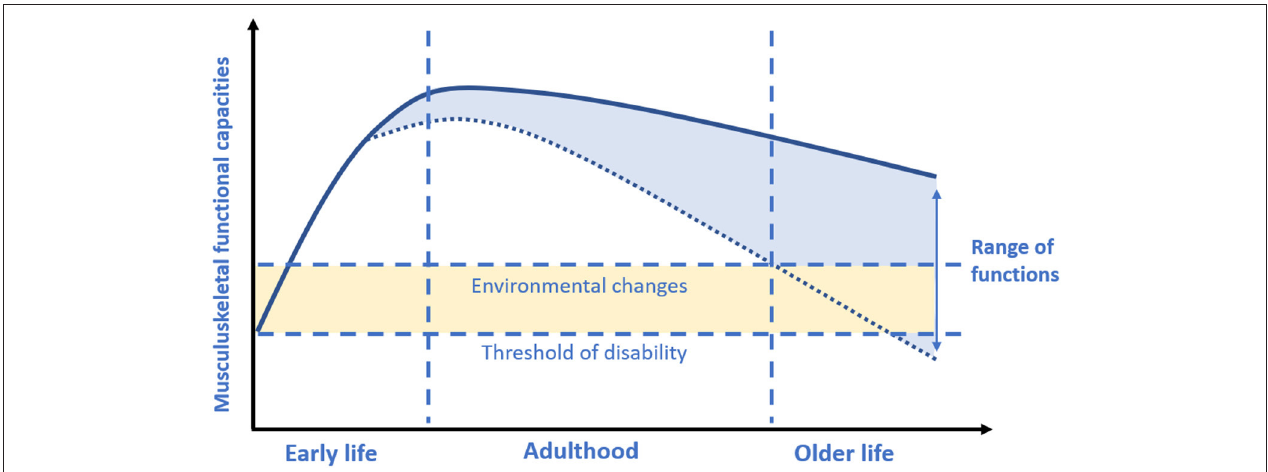
FIGURE 2 | Musculoskeletal functional capacities across the lifespan. Based on concepts and findings by Kuh (7), Sayer et al. (19), and Cruz-Jentoft et al. (17). During early life each person rapidly accumulates his/her functional capacities in body functions (i.e., muscle) or structures (i.e., bone mass) to reach a peak or a plateau at maturity (i.e., nearly at the end of adolescence period). Afterwards, gradually starts a decline with age. The greater the peak, the slower the consequent decline. However, it should be considered that the rate of decline may be also largely driven by environmental factors during adult